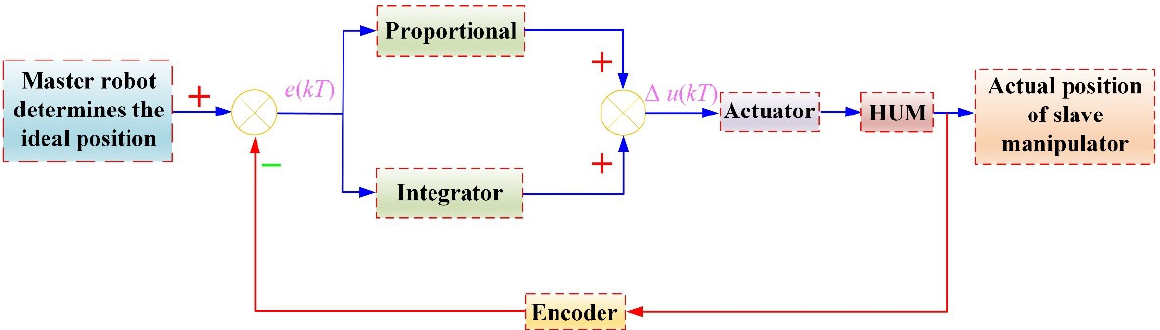
Figure 9. Control schematic of rotary motion.